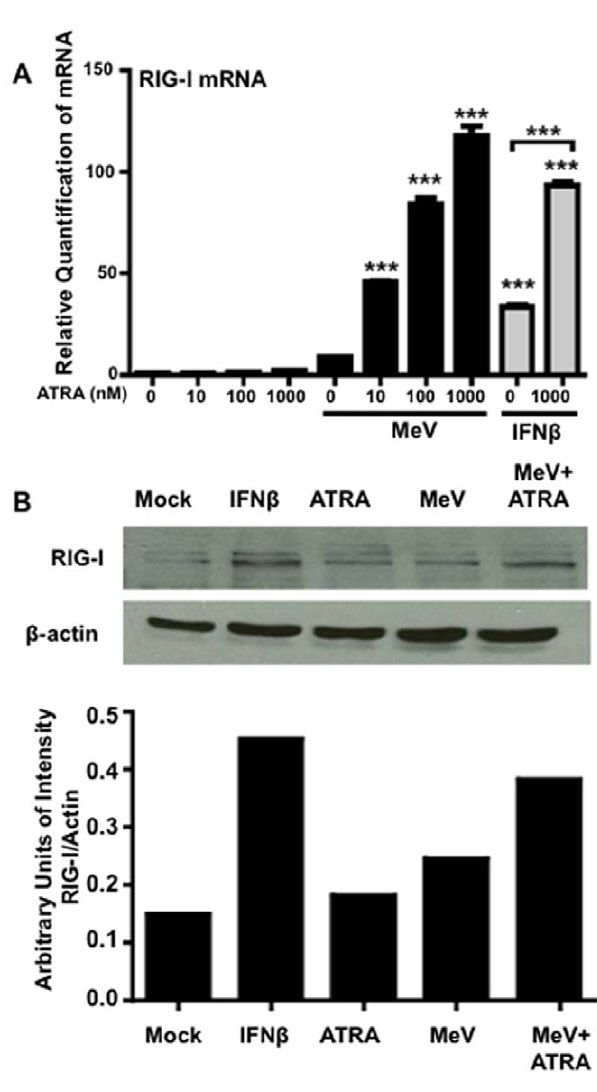
Figure 1. RIG-I expression is regulated by MeV and ATRA. (A) U937 cells were infected with MeV at an MOI of 0.1 and treated with increasing doses of ATRA or DMSO for 24 hours. Some samples were also treated with 1000 U/mL IFN b for 24 hours, with or without ATRA. RNA was extracted and analyzed for RIG-I expression by qPCR. Data presented are representative of three experiments performed in triplicate (N=3). (B) U937 cells were infected with MeV at an MOI of 0.1 and treated with ATRA or DMSO (1 m M) for 48 hours, or with 2000 U/mL IFN b as a positive control. Samples were analyzed by western blot for RIG-I and b -actin expression and quantified. ***p , 0.001.